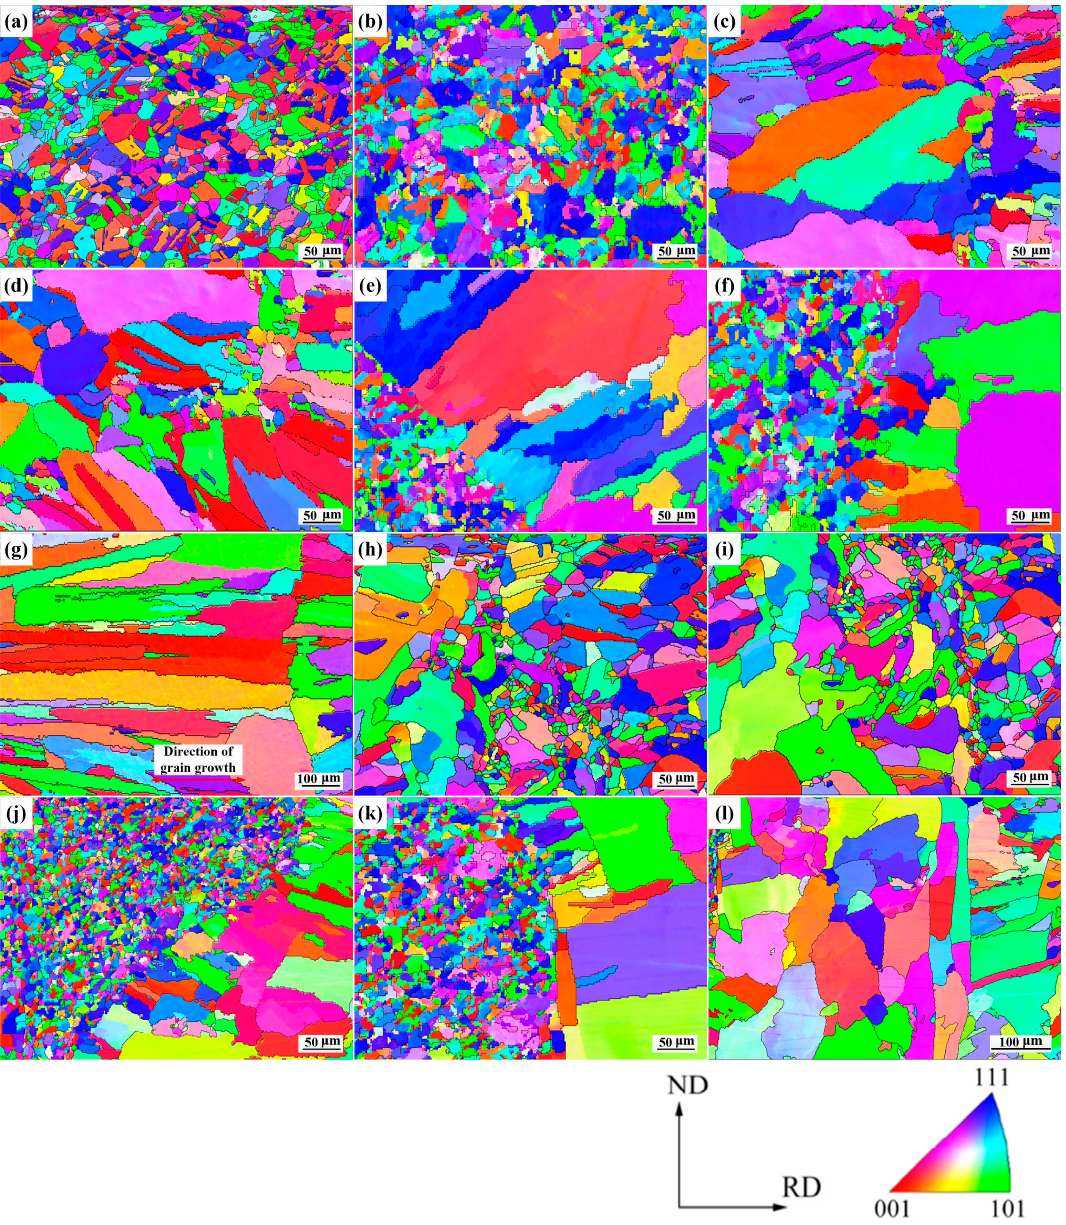
Figure 10. EBSD-IPF micrographs of local weld sub-regions: ( a ) Cu-BM; ( b ) SS-BM; joint 1: ( c ) C1; ( d ) C2; ( e ) S1; ( f ) S2; ( g ) weld zone; joint 2: ( h ) C1; ( i ) C2; ( j ) S1; ( k ) S2; and ( l ) weld zone.